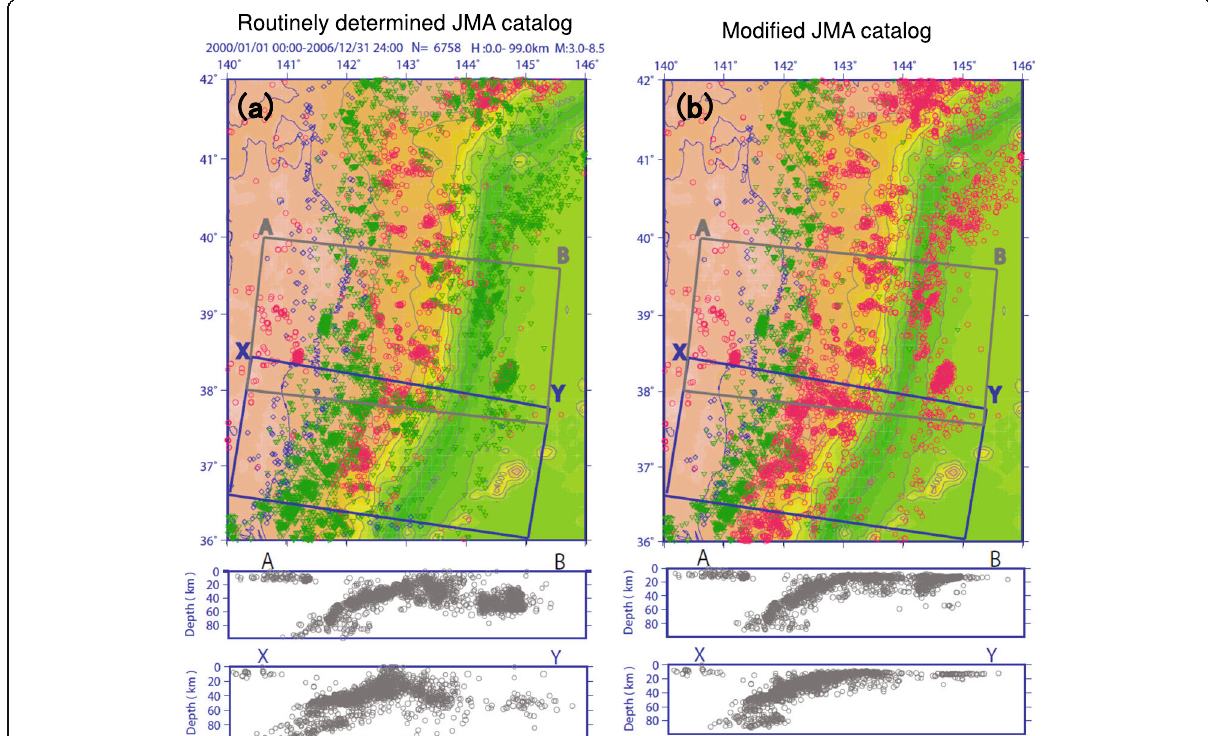
Fig. 8 Depth corrections of offshore earthquakes from the JMA catalog (example 1). a Routinely determined M ≥ 3 earthquake hypocenters in JMA catalog during 2000 – 2006 and b corrected hypocenters using the sP waves by Umino et al. (1995) for the same earthquakes (left